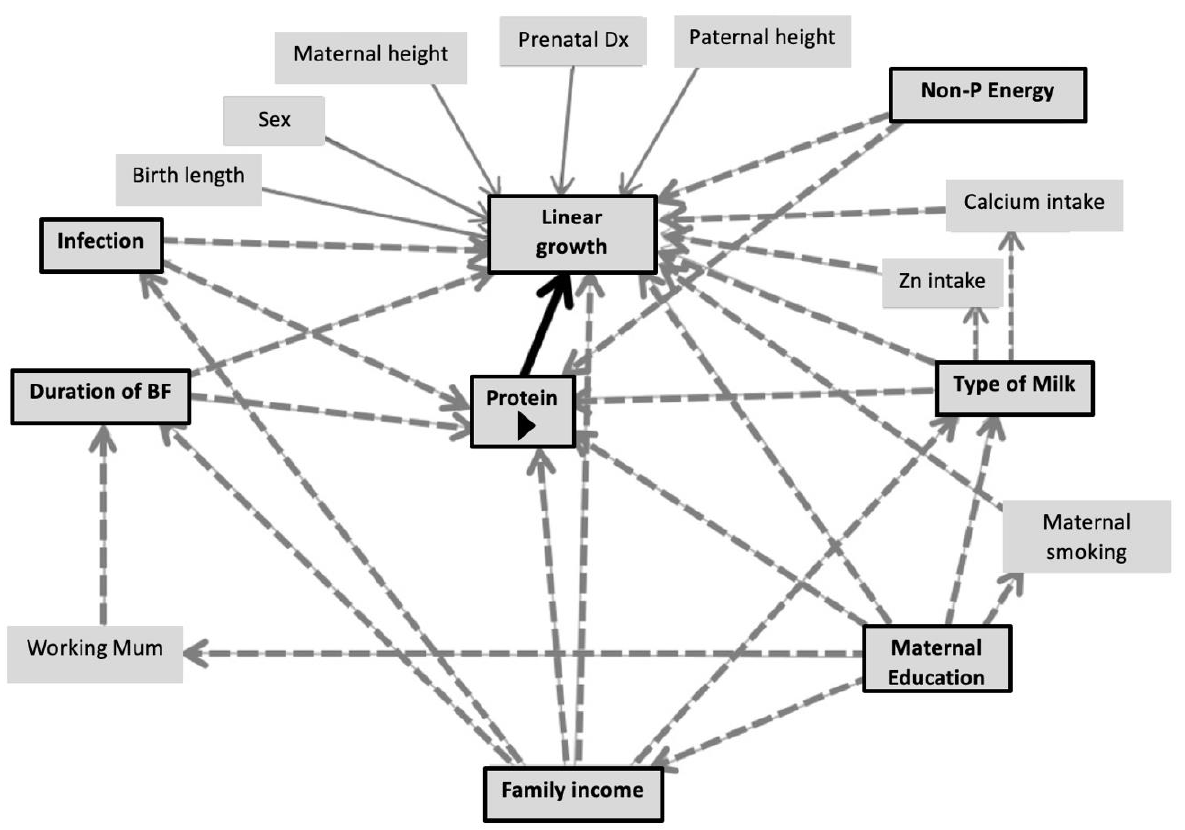
Figure 3. Directed acyclic graphs demonstrating co-variates of the association between protein intake and linear growth/ponderal growth.